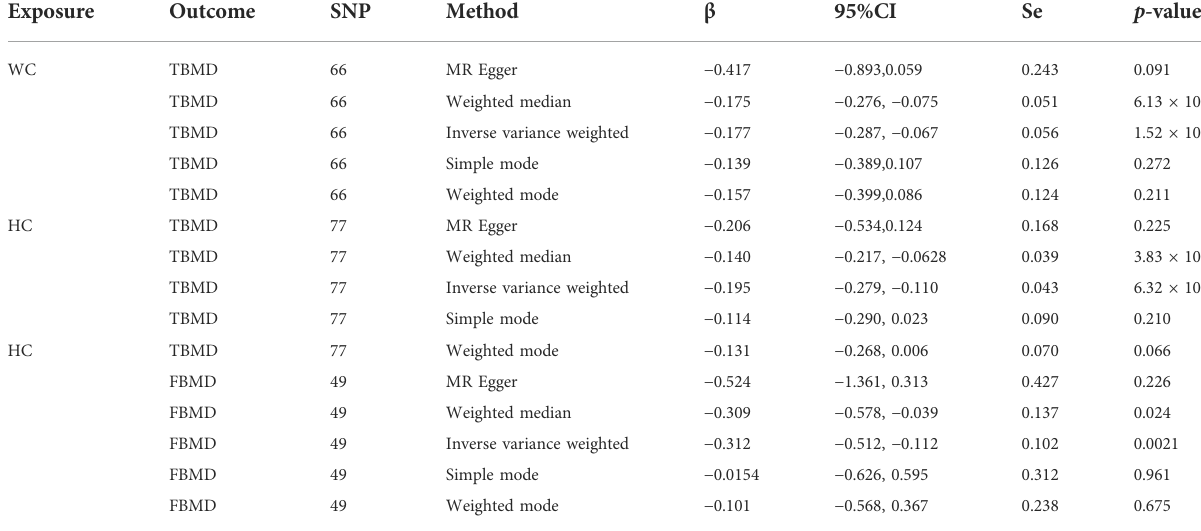
TABLE 1 Summary of Mendelian randomization results.